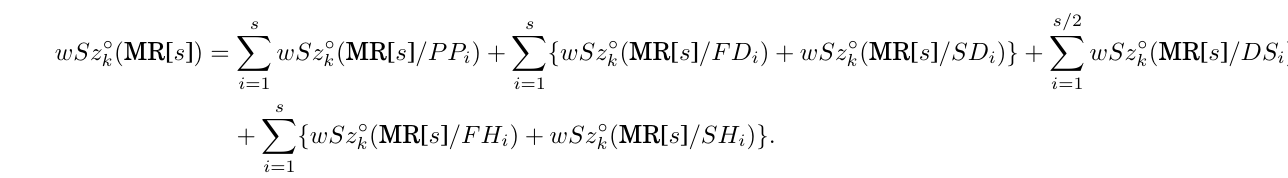
Figure 2: Quotient graph corresponds to the slanting bonds of two diametrically-opposite melem units. For 1 ≤ i ≤ s/ 2 , let DS i be a Θ ∗ -class encompassing the slanting bonds of two diametrically-opposite melem units of MR[ s ]. The vertex and edge strength-weighted quotient graph MR[ s ] /DS i is shown in Figure 2. As we constructed for MC[ s ], let FH i and SH i be the Θ -classes for horizontal bonds for MR[ s ]. Here FH i and SH i generate an identical quotient graph K 1 , 1 , but the vertex weights, vertex strengths, edge weights, edge strength for FH i and SH i are 4 , 15 s − 4 , 3 , 18 s − 5 , 10 , 12 , 2 and 9 , 15 s − 9 , 9 , 18 s − 12 , 16 , 21 , 3 respectively. We compute the required indices by simplifying the following